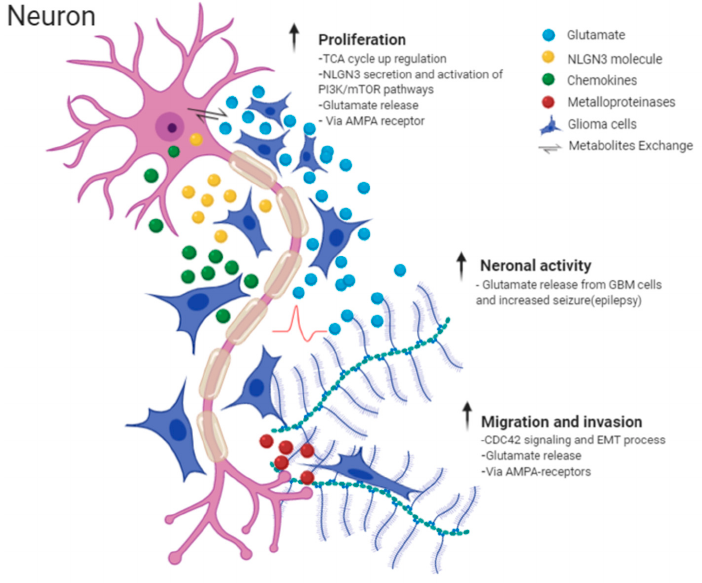
Figure 5. Illustrative picture of Perineuronal satellites events and major molecular mechanisms, which explain the interaction between neurons and neural activity and glioma cells. Images are created with BioRender.com Table 1. Summary of studies investigating the Perineuronal Satellitosis process within brain tumour in in vivo and in vitro models along with the molecular mechanism proposed. Bold: is a summary title which encompass different process.